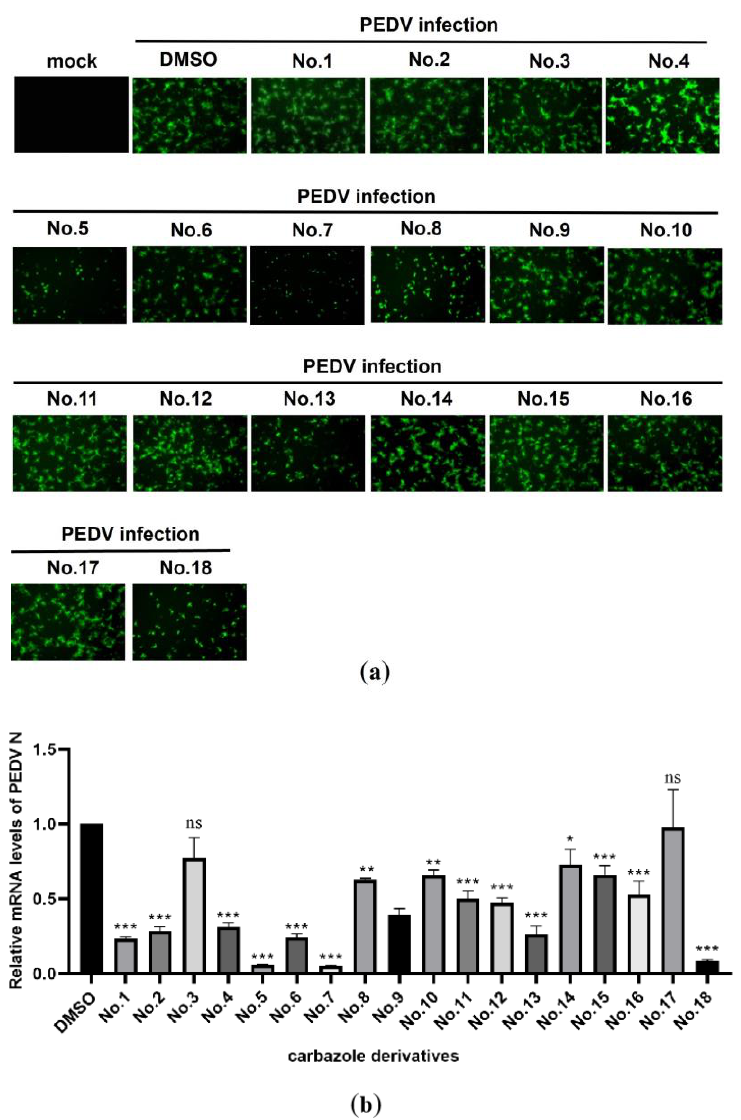
Figure 2. Evaluation anti-PEDV activities of 18 carbazole derivatives. Vero-81 cells were treated with 18 kinds (from No.1 to No.18) of carbazole derivatives, and then infected with EGFP-PEDV for 24 h. ( a ) The fluorescence in the cells were observed by fluorescence microscope. ( b ) RNA was extracted from PEDV-infected or non-infected vero-81 cells. The relative mRNA level of PEDV N was determined by qRT-PCR. * p < 0.05; ** p < 0.01; *** p < 0.001; ns not significant.